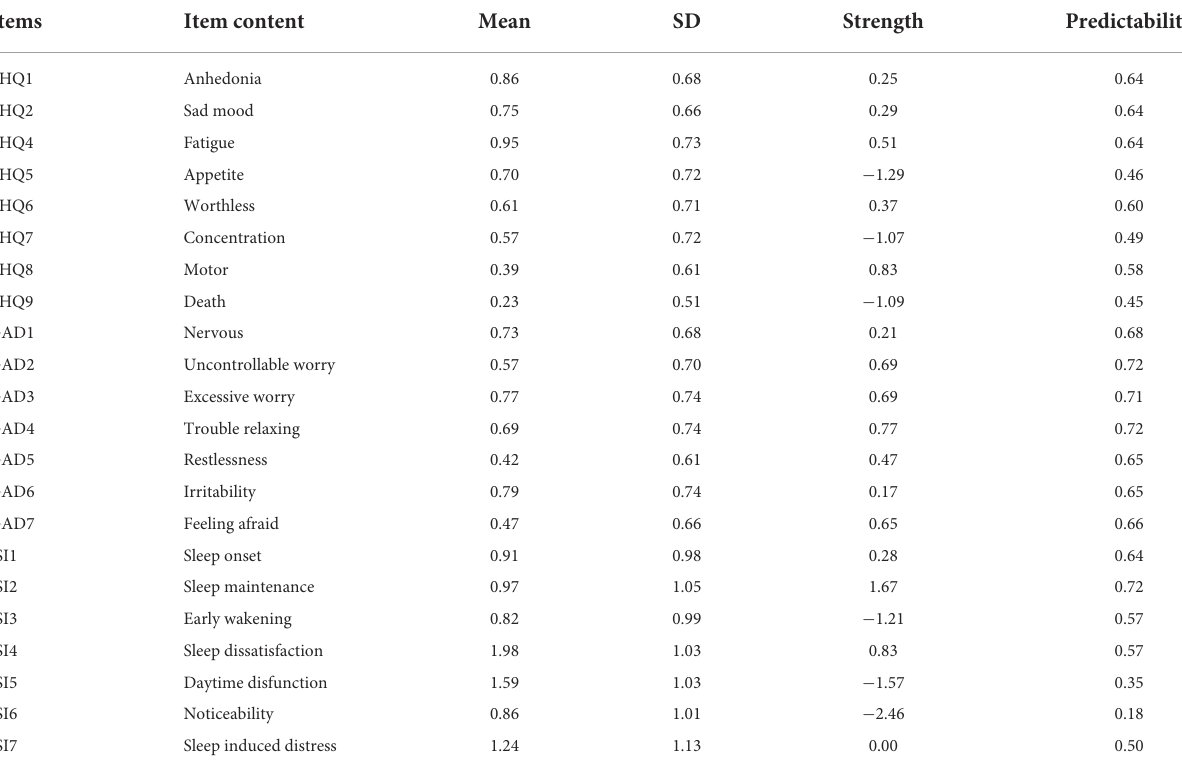
TABLE 2 Descriptive statistics of the items in the insomnia-depression-anxiety